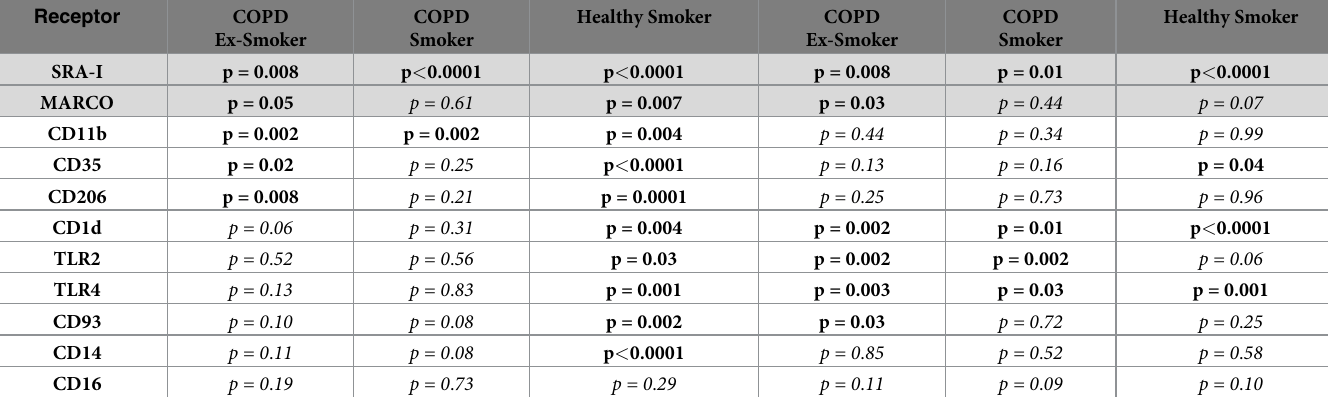
Table 2. NTHI and SP-mediated reductions in bacterial recognition receptor expression on MDMs from subjects with COPD and